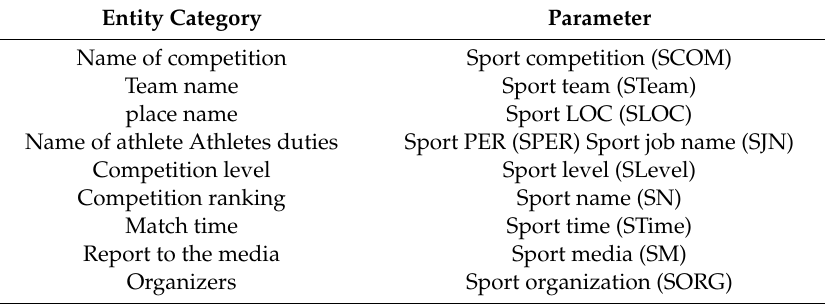
Table 1. Data annotation specifications using